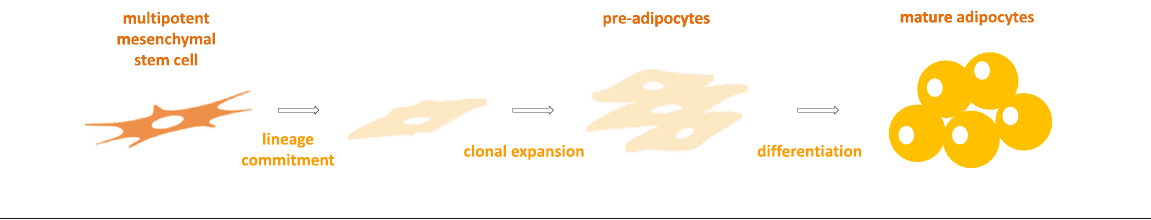
Table 1 White adipose tissue in brief White adipose tissue achieves metabolic functions through the release of signaling molecules, such as adipokines, and hundreds of diverse factors, including classical hormones such as leptin, growth factors such as IGF-1 and PDGF, and cytokines such as IL-6, IL-8, or TNF- α acting as inflammatory mediators [163], comprehensively linked to appetite regulation and insulin sensitivity. Growing evidence supports the notion that chronic low-grade inflammation is a basic characteristic of obesity contributing to the establishment of insulin resistance into the target organs, including the adipose tissue, liver, and muscle, and the vascular system [164]. Excess of nutrients, such as lipids and glucose, may simultaneously trigger inflammatory re- sponses, which further disrupt metabolic function, enhancing stress and inflammation. Accordingly, the nutrition – immunity theory suggests that in the adipose tissue, overnutrition-induced obesity triggers low-level inflammatory processes [165]. Anomalous fat accumulation has been shown to in- crease pathogenic risks since adipose tissue remains in a state of subclinical chronic inflammation [166]. This condition is strictly related to a massive recruitment of macrophages and to an increased immune cell proliferation activation – infiltration connected to adipocyte hypertrophy and an im- paired adipogenesis [167]. The latter process is tightly controlled by a mixture of regulatory signals including endocellular transcription factors, extra- cellular circulating hormones [168], and additional post-transcriptional regulators of gene expression [60, 169 – 172]. Adipogenesis is the process during which fibroblast-like pre-adipocytes differentiate into mature adipocytes, a complex mechanism involving cell commitment, clonal expansion, and terminal differentiation [173]. More in detail, differentiation from pre-adipocytes into mature adipocytes is a key step orchestrated by several transcription factors such as the peroxisome proliferator-activated receptor- γ (PPAR γ ) and CCAAT/enhancer-binding pro- teins (C/EBPs) that coordinately control expression of genes required for adipocyte phenotypes. C/EBP β and C/EBP δ are induced by adipogenic stim- uli and represent primary regulators of adipogenesis. Targets of C/EBP β and C/EBP δ are the promoters of the genes encoding critical adipogenic factors such as C/EBP α and PPAR γ , as well as the sterol regulatory element-binding protein (SREBP1), the key regulator of lipogenic genes. The protein encoded by the C/EBP α intronless gene is a leucine zipper transcription factor which can bind to specific promoters and enhancers as a homodimer or it can form heterodimers with the related proteins C/EBP β and C/EBP γ . The C/EBP α protein has been shown to bind to the promoter and to also modify the expression of the leptin gene, playing a central role in body weight homeostasis. C/EBP α is sufficient to trigger differentiation of pre- adipocytes into mature adipocytes [174]. Peculiarly, PPAR γ directly triggers endogenous C/EBP α transcription. In turn, C/EBP α activates the PPAR γ gene through a positive feedback loop, thereby promoting adipogenesis [168]. Together, PPAR γ and C/EBP α promote the expression of genes in- volved in insulin sensitivity, in lipogenesis and lipolysis, and, ultimately, in the terminal differentiation and mature functions of adipocytes. The com- plex series of events governing adipose cell commitment and differentiation also includes anti-adipogenic signaling cascade controlled by Wnt, BMPs, TGF- β , and hedgehog [175]. As expected, an increase in size (hypertrophy) and number (hyperplasia) of adipocytes causes higher level of fat mass and energy storage in the adipose tissue, possibly ending in increased obesity